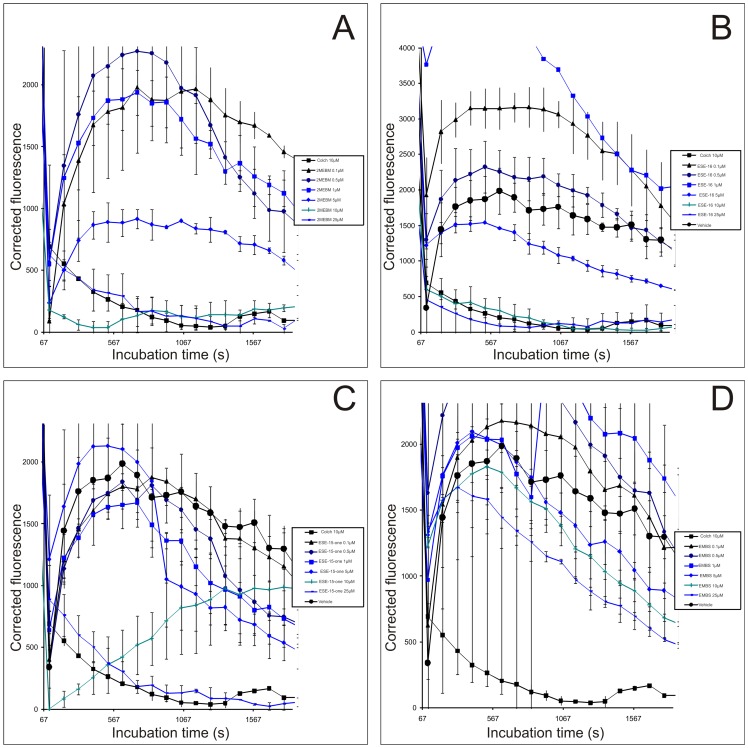
Tubulin polymerization assay.Tubulin was incubated with the compounds ((A), ESE-16 (B), ESE-15-one (C) and EMBS (D)), as described in the methods section. This assay showed that ESE-16 had a pronounced effect comparable with that of colchicine.